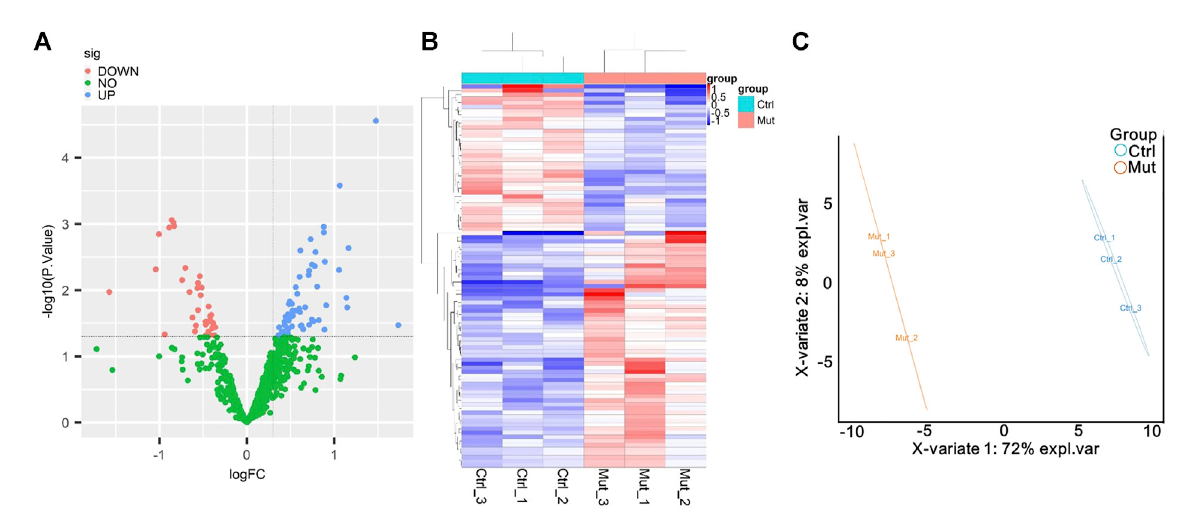
FIGURE 2 Analysis of the differentially expressed proteins (DEPs) between the MMA patients and healthy control. (A) Volcano plot of DEPs. The blue dot represents DEPs upregulated, and the red dot represents DEPs downregulated in the MMA patients compared with the healthy control. (B) Cluster heatmaps ofsigni fi cantDEPs. MUT represents theserum that wasobtained from theMMA patients, and Ctrlrepresents theserum obtained fromthe healthy control. Each column represents a sample, and the row shaded in red represents upregulated, while shaded in blue represents downregulated when MMA patients vs. healthy control. (C) PL-SDA diagram of six samples based on DEPs. Oval indicates the 95% con fi dence intervals.